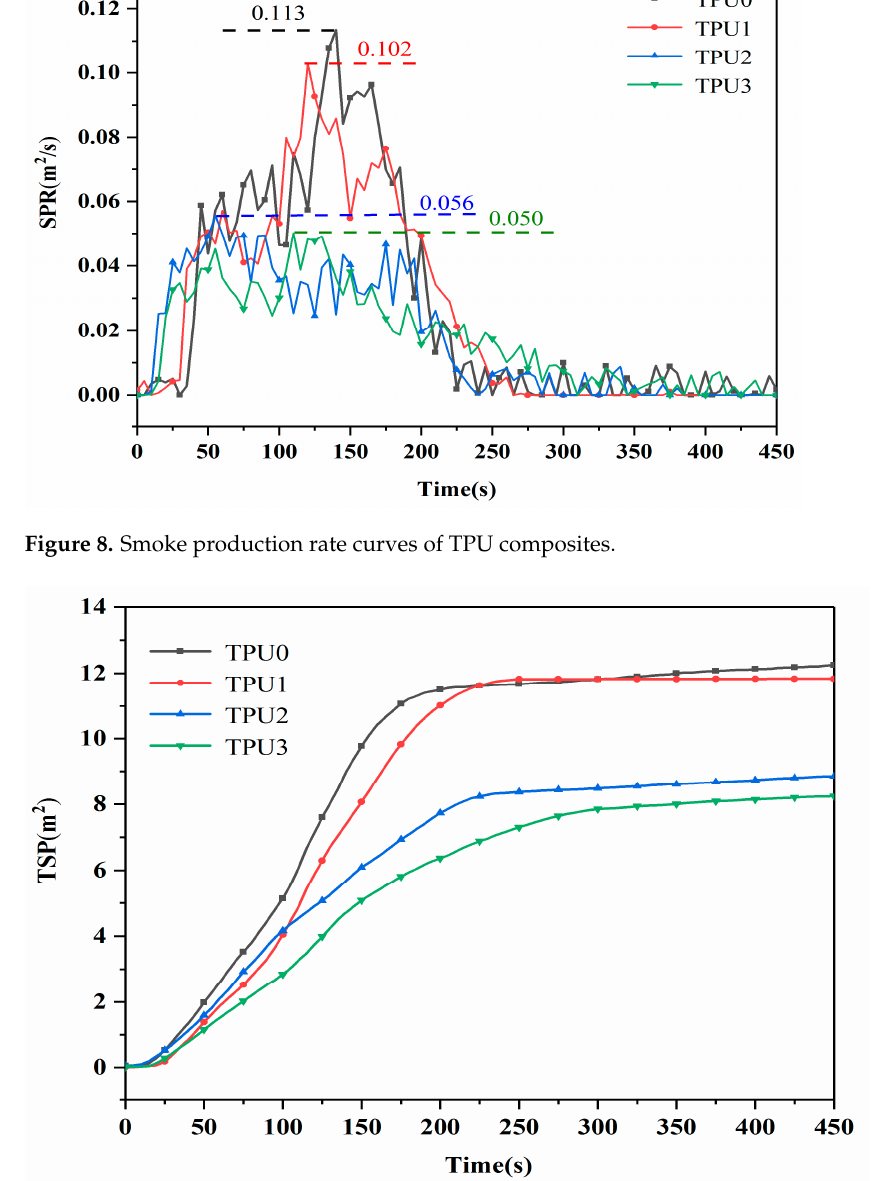
Figure 9. Total smoke production curves of TPU composites.